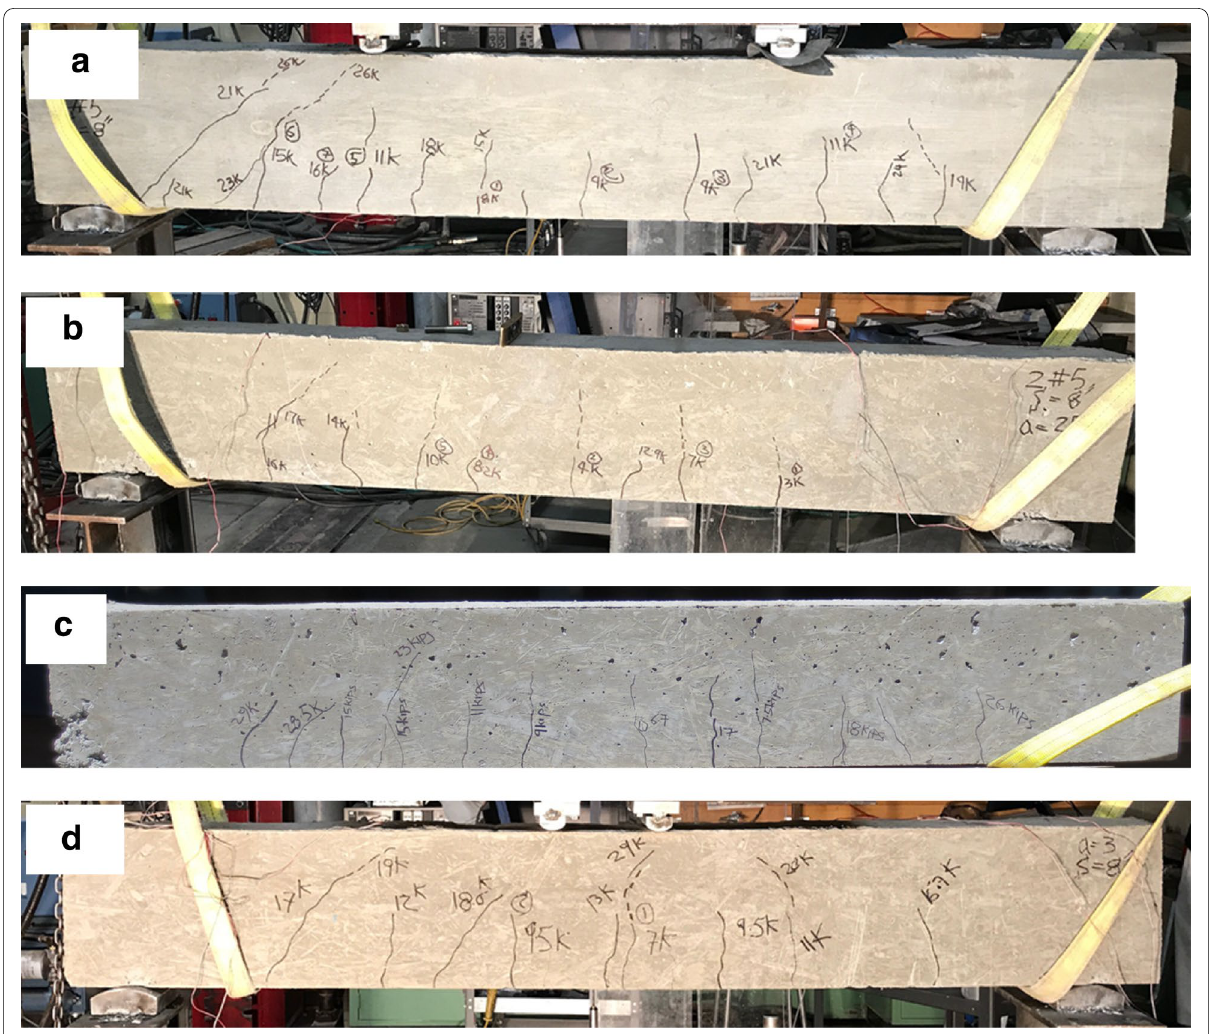
Fig. 6 Failure mode of ( a ) 4CONT-M8-2, ( b ) 5CONT-M8-2.5, ( c ) 6CONT-M8-3, and ( d ) 7CONT-M3-2.5.